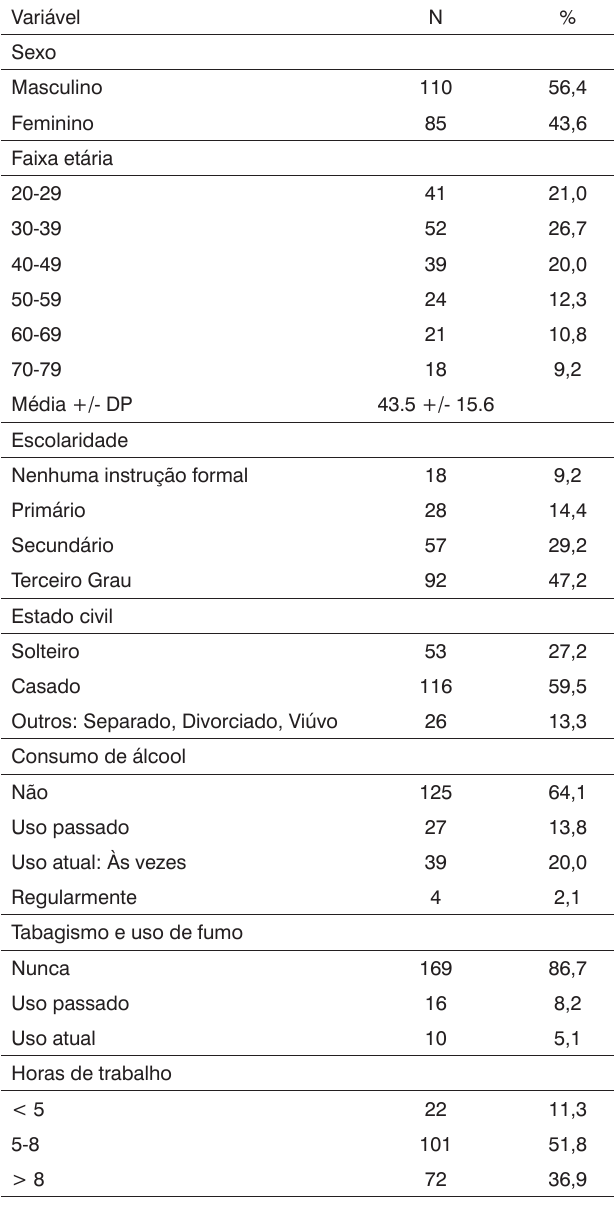
Tabela 1. Características sociodemográficas dos pacientes.